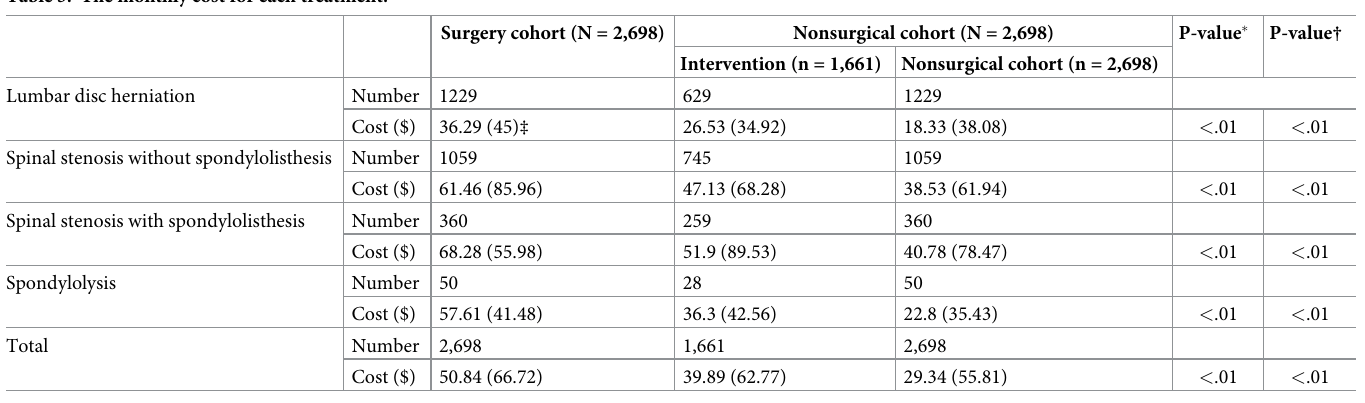
Table 3. The monthly cost for each treatment.